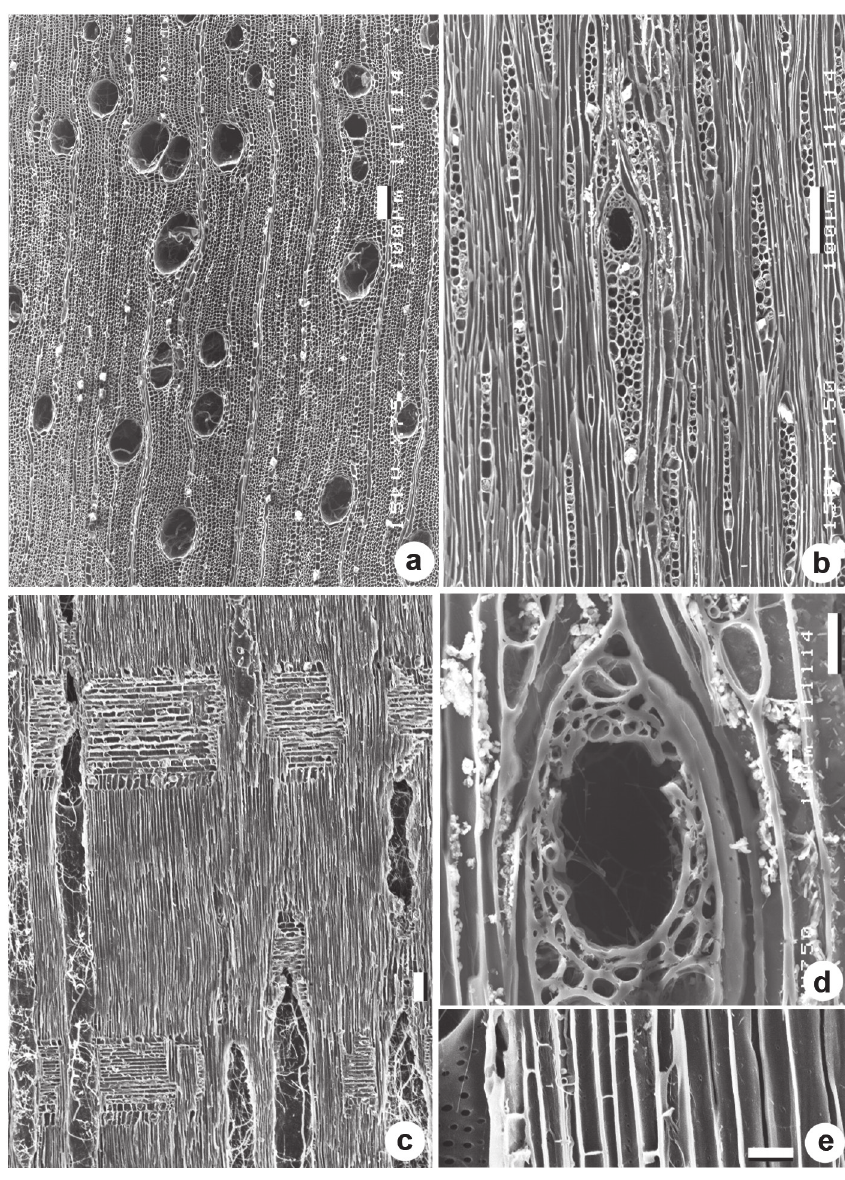
Figure 2. Astronium graveolens (RBw 3733). Uncoated, IBCCF/UFRJ. - a : Transverse section. - b : Tangential section - c : Radial section. - d : Radial canal. - e : Septate fibres. Bars = 100 µm ( a-c ) and 20 µm ( d-e